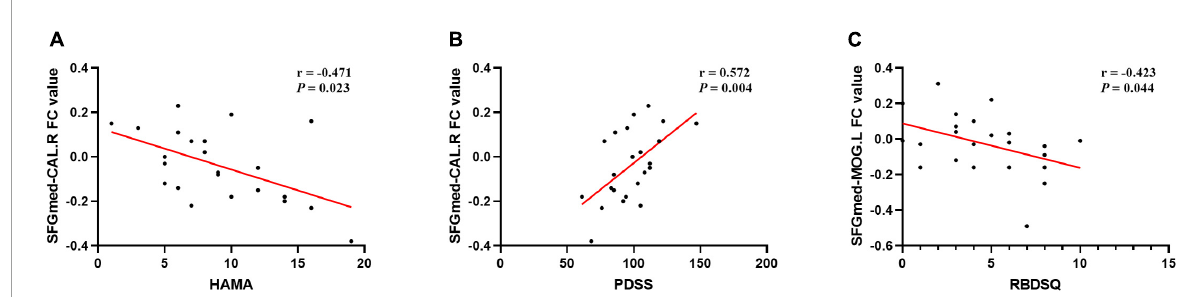
FIGURE5 Correlation analysis of FC and clinical scale data in MH patients. A significant correlation between (A) SFGmed-CAL.R FC value and HAMA score ( rs = –0.471, P = 0.023); (B) SFGmed-CAL.R FC value and PDSS score ( rs = 0.572, P = 0.004); (C) SFGmed-MOG.L FC value and RBDSQ score ( rs = –0.423, P = 0.044); PD, Parkinson’s disease; MH, minor hallucination; FC, functional connectivity; SFGmed, medial superior frontal gyrus; CAL.R, right calcarine sulcus; MOG.L, left middle occipital gyrus; HAMA, Hamilton Rating Scale for Anxiety; PDSS, Parkinson’s disease sleep scale; RBDSQ, rapid eye movement sleep behavior disorder screening